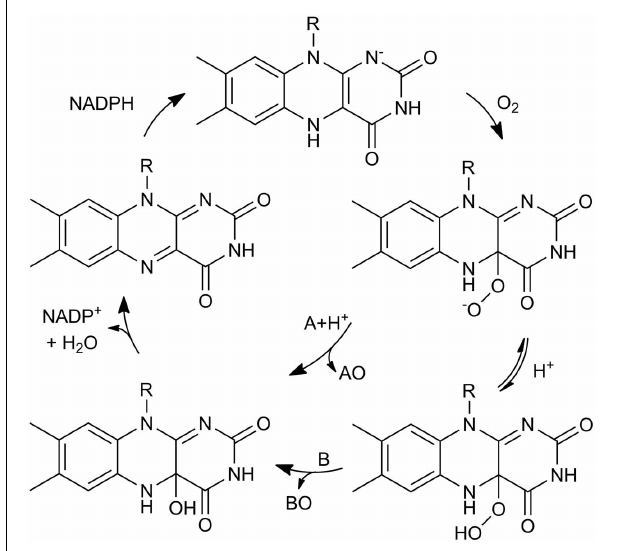
FIGURE 1 | Catalytic mechanism of Type I Baeyer-Villiger